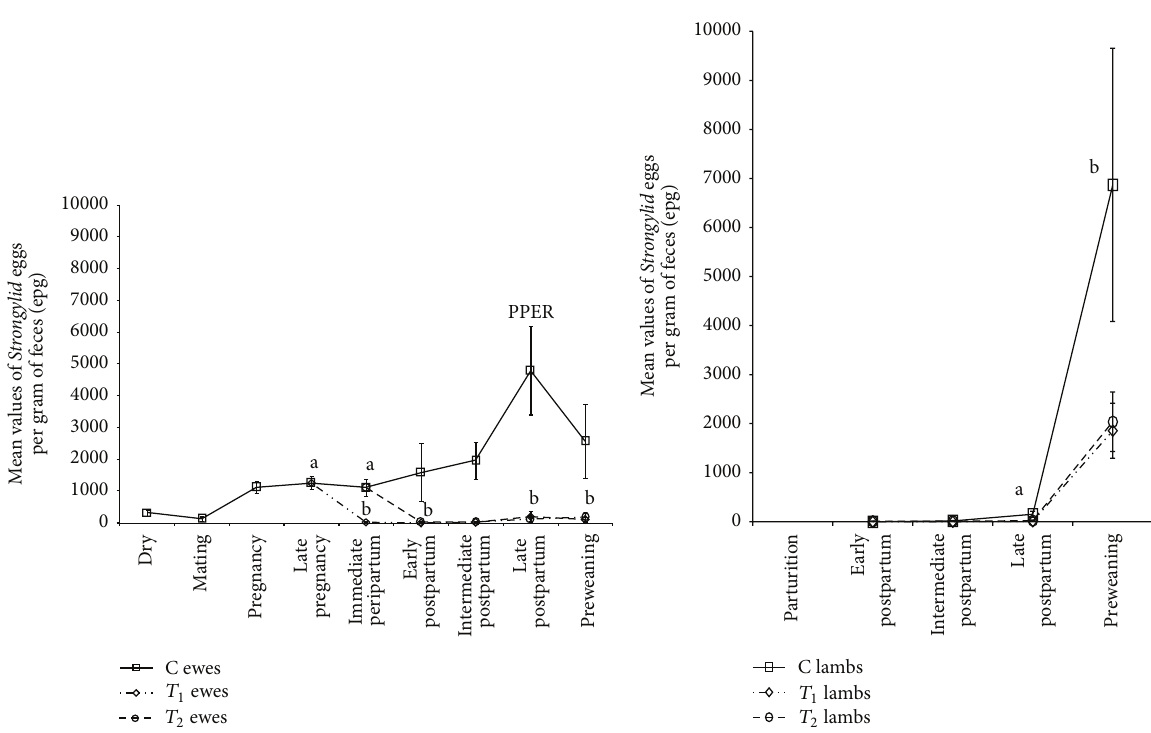
Figure 2: Mean gastrointestinal parasite burdens ( ± standard error of mean) registered during one complete reproductive cycle in ewes and their offspring. (a) shows the peak in FEC at late pregnancy in C ewes (PPER) and the significant ( b ) and sustained FECR induced by 𝑇 1 and 𝑝 < 0.05 ) preventing the PPER (PPER 𝑇 2 peripartum strategic treatment with moxidectin (two-factor ANOVA, Pre ). (b) shows the significant increase in FEC at preweaning ( b ) in ewes’ offspring (two-factor ANOVA, 𝑝 < 0.05 ). Adult ewes 𝑛 = 43 (14 C, 15 𝑇 1 , and 14 𝑇 2 ). Suckling lambs 𝑛 = 58 lambs (18 born from C ewes, 20 from 𝑇 1 ewes, and 20 from 𝑇 2